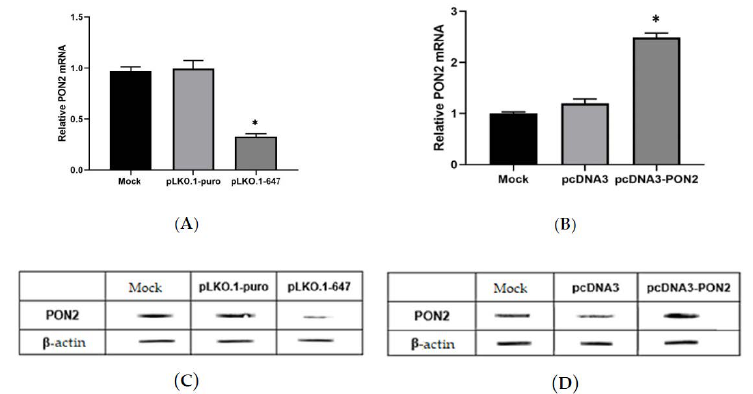
Figure 1. Paraoxonase-2 ( PON2 ) expression levels in T24 cells. In order to induce PON2 silencing or overexpression, T24 cells were transfected with pLKO.1-647 or pcDNA3-PON2, respectively. Control cells were treated with empty vectors (pLKO.1-puro or pcDNA3) or with transfection reagent only (mock). Real-Time PCR was used to evaluate PON2 mRNA levels in cells transfected with plasmids inducing enzyme down- (panel A ) or upregulation (panel B ) compared with the mock. Lysates obtained from T24 cells were analyzed by Western blot to evaluate PON2 protein levels upon enzyme knockdown (panel C ) or overexpression (panel D ). All values reported in panels A and B are expressed as the mean ± standard deviation (* p <